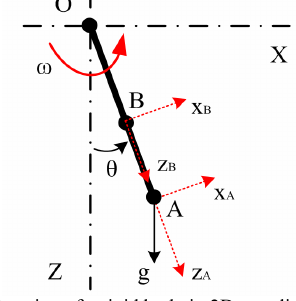
Fig.1 Rotation of a rigid body in 2D coordinate